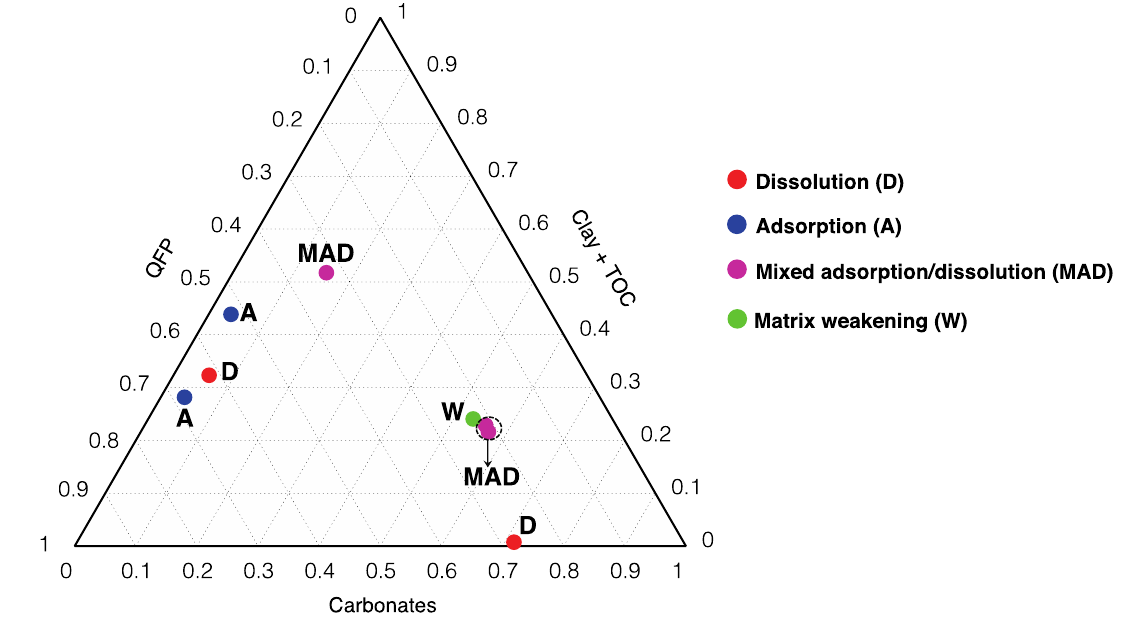
Figure 14. Ternary diagram by processes affecting permeability.